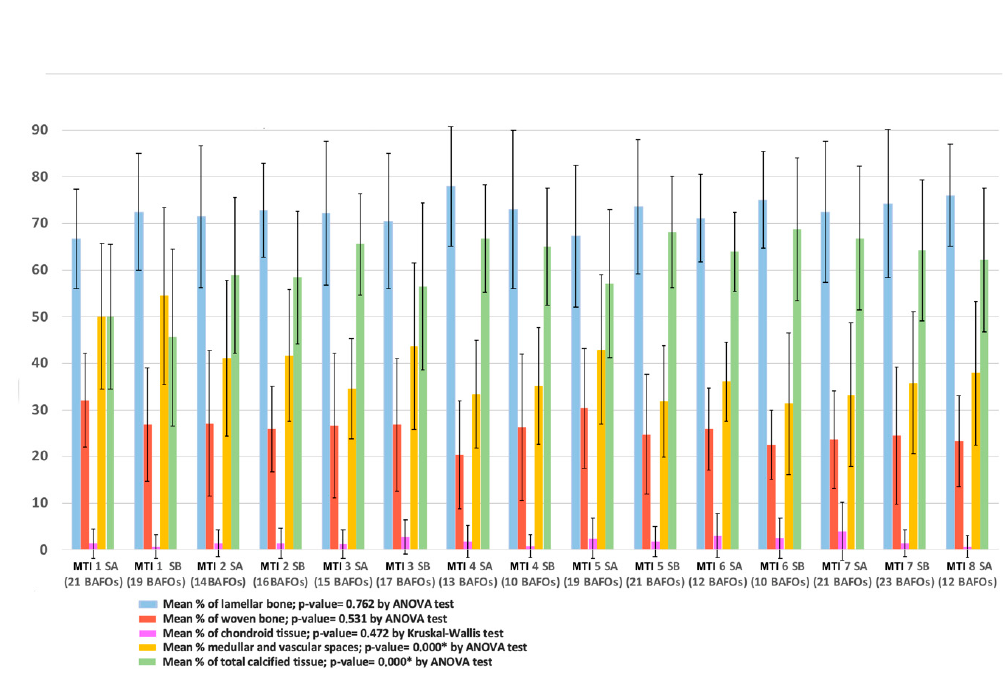
Figure 4. Distribution of calcified tissue considering each sample. MIT = mini transitional implant; SA and SB = Segment A and Segment B of sample (see Figure 1). The number of BAFOs analyzed is described below each set of bars belonging to a sample. No significant differences were observed in the distribution of the types of bone tissue. * Significant differences were observed in the distribution of vascular spaces and general calcified tissue between the samples. Table 1. Summary of quantitative analysis of bone tissue observed in the BAFOs (Total samples = 15). For BAFO, %Bf, and %BIC definitions see the methodology segment. SD = standard deviation.